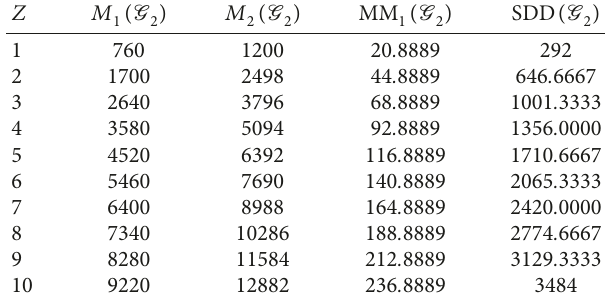
Table 8: Comparison between different TIs of (TM-TCNB) 2 .